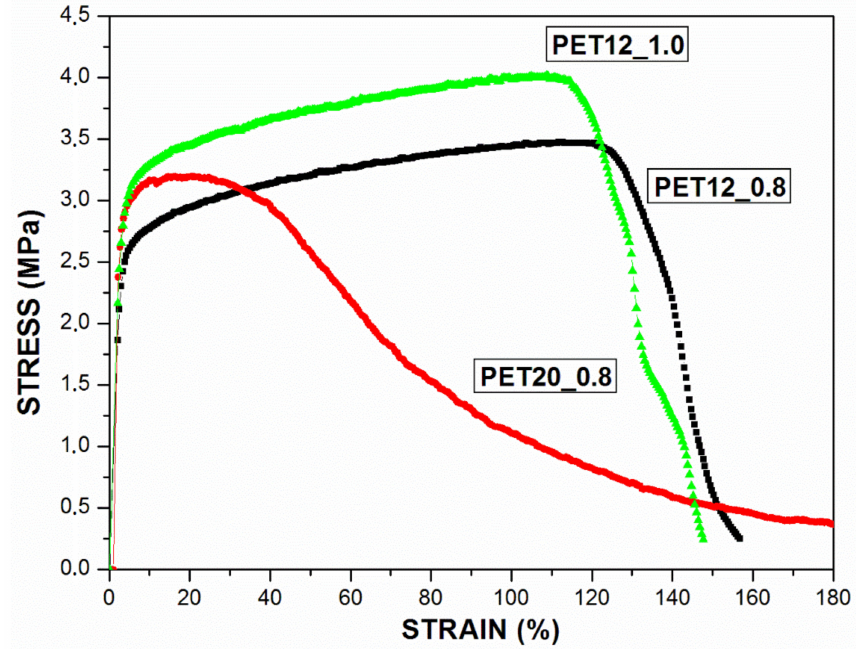
Figure 2. Tensile stress–strain curves for the PET20_0.8, PET12_0.8 and PET12_1.0